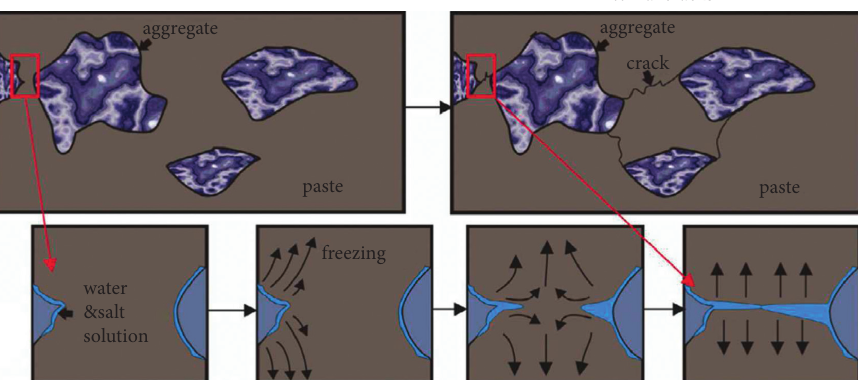
Figure 8: Propagation of internal cracks of HVFA concretes during F-Tcycles in the presence of salt, reproduced from [78], with permission from Elsevier,